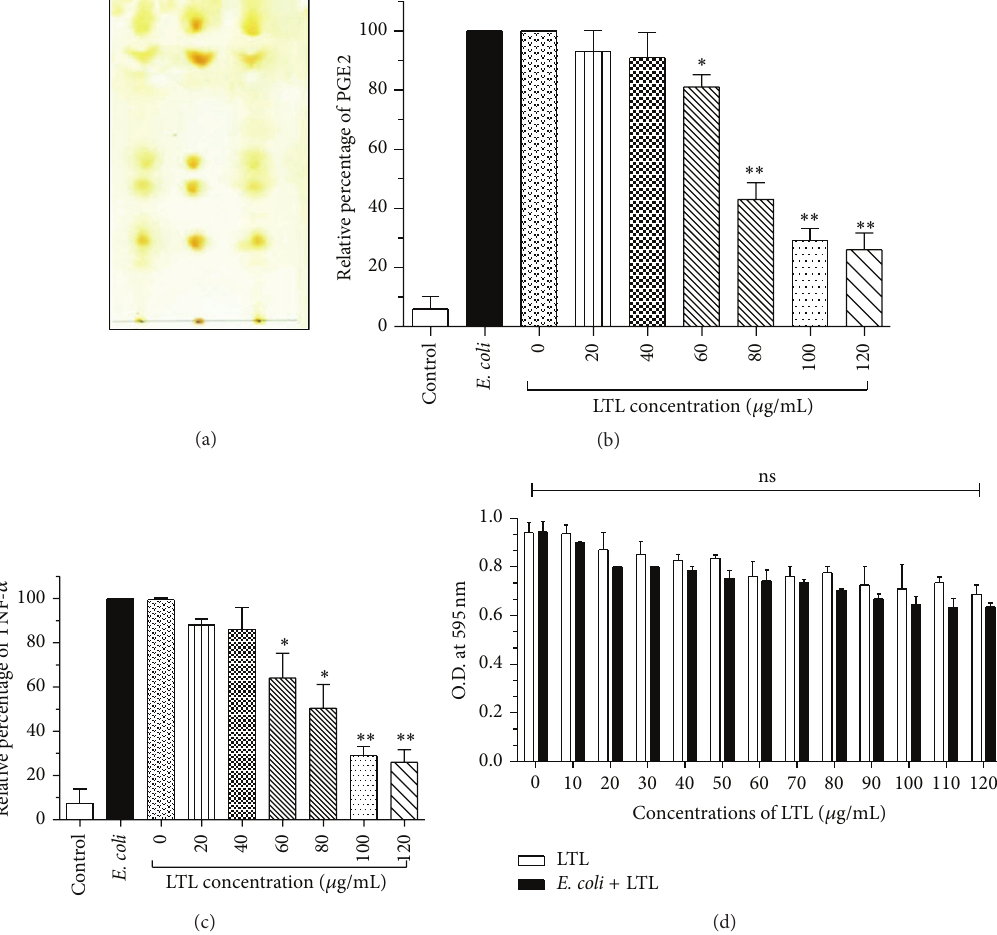
Figure 1: Thin-layer chromatography (TLC) profile of leishmanial total lipid or LTL (a). Effect of LTL on production of PGE2 (b) and TNF- 𝛼 (c). The mouse peritoneal macrophage cells were preincubated with LTL in the presence or absence of heat-killed E. coli (O18:K1; 1 × 10 8 CFU/mL) for 24 h and the optical density was determined by ELISA method. (d) The cytotoxicity of LTL on peritoneal macrophage cell measured by MTT assay for 24 h and OD determination at 595 nm. The data are reported as the mean ± SEM of triplicate experiments. ( ∗ 𝑃 < 0.05 , ∗∗ 𝑃 < 0.01